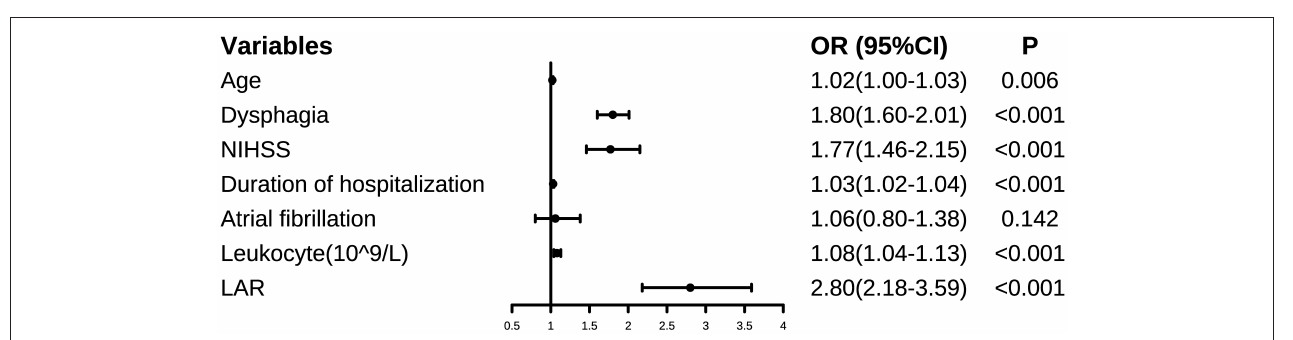
FIGURE 3 | Forest plot of odds ratios (OR) for SAP. An OR > 1 meant an increased risk of SAP, and an OR < 1 meant the opposite.